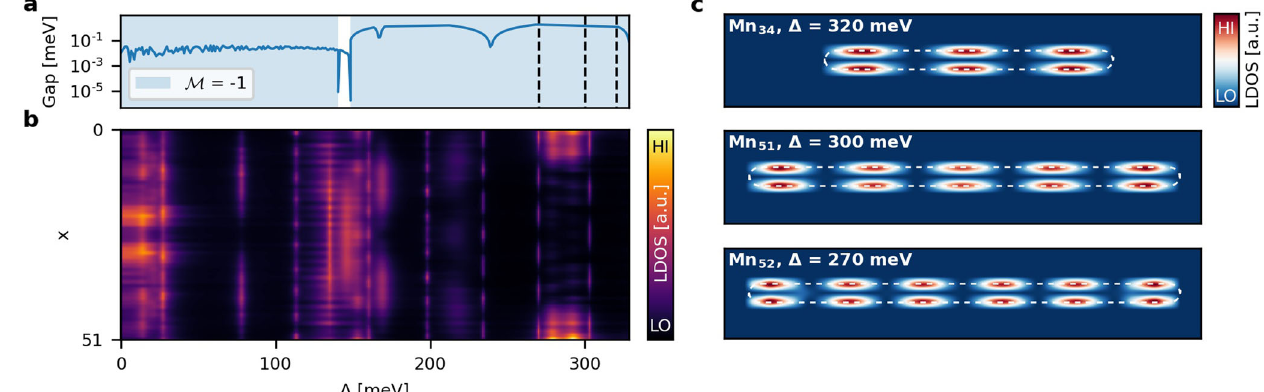
Fig. 2 Analysis of DFT-based superconducting 80-band model. a Topological phase diagram as a function of the bare superconducting amplitude Δ (topological region in blue with M ¼ (cid:2) 1 , and white is trivial). The gap size is shown as the blue curve. b Zero-energy LDOS as a function of lattice site along x and Δ (the y -dependence has been summed up such that the LDOS appears one-dimensional) for chain length N = 51. c Examples of zero-energy LDOS( x , y ) for various values of Δ , as indicated by the dashed vertical lines in ( a ), with pronounced side features. Chain length and Δ are given within the panels. The theoretical LDOS is always evaluated in the plane of the chain (for a discussion of the three-dimensional LDOS see Supplementary Note